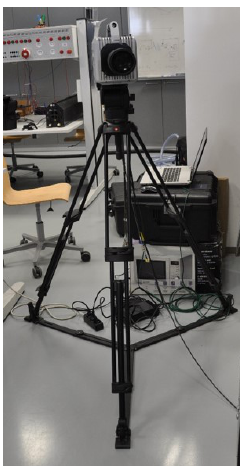
Figure 2. Photron High Speed Camera FASTCAM